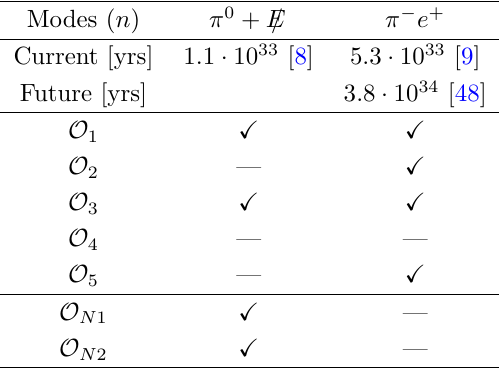
Table 2 . Same as table 1 but for neutron decay modes. Here again, the discovery of (cid:25) 0 + E= with simultaneous absence of (cid:25) (cid:0) ‘ + suggests the existence of an e(cid:11)ective operator containing a light sterile